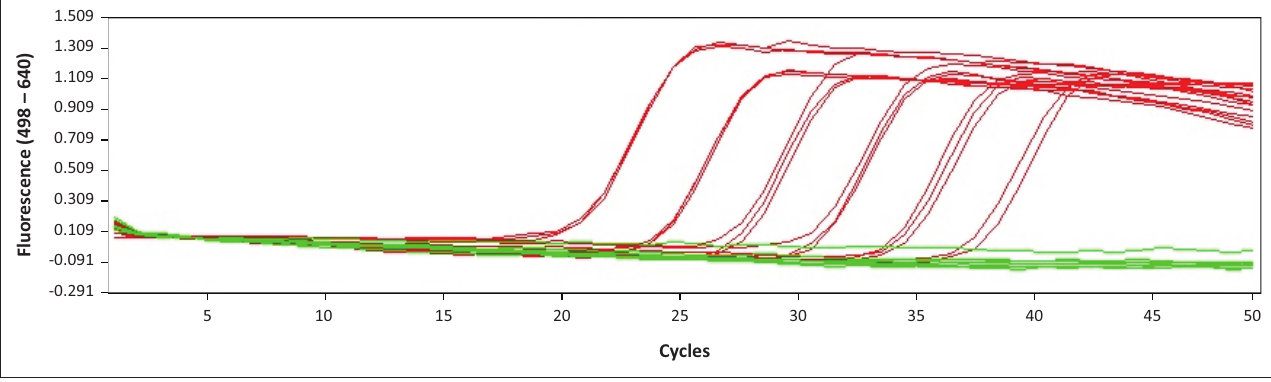
FIGURE 3: Amplification curves for the validated duplex real-time polymerase chain reaction for detection of the stx gene